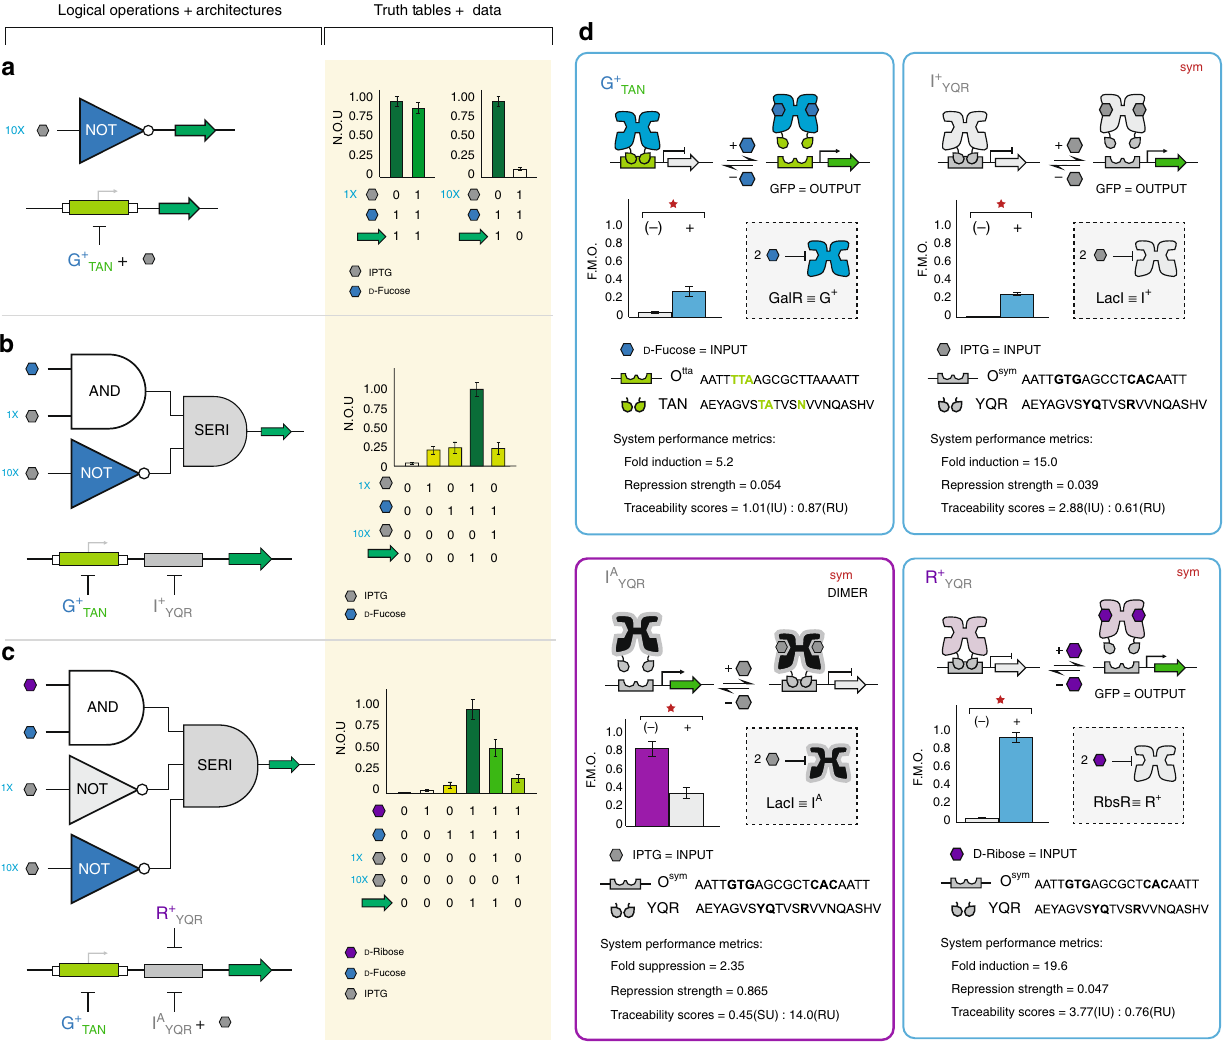
Fig. 6 Combinatorial logic via the SERI architectures and bandpass operations. a IPTG acts as a competitive inhibitor to GalR, preventing GFP expression upon addition of fucose in the presence of 10 mM IPTG. When 1 mM IPTG is present, GalR is not inhibited. Values represent the mean of n = 6 biological replicates, and the error bars represent the 95% CI or ~2x s.e.m. b NOT logic function can be incorporated into a SERI circuit by utilizing IPTG as a competitive inhibitor to GalR, resulting in an apparent bandpass fi lter, where GFP output is achieved only in the presence of certain IPTG concentrations. Values correspond to n = 18 biological replicates. c A second NOT gate can be added by introducing an I A transcription factor; this represents a more granular bandpass fi lter where the output can be gradually decreased upon addition of different concentrations of IPTG. Values correspond to n = 12 biological replicates except for the fucose, ribose, 1 mM IPTG state where n = 6 biological replicates. d Performance cards for each of the transcription factors involved. All data have been normalized to the maximum value of 20,000 GFP/OD 600 a.u. Note: the I A YQR suppressor used in c was reduced to a dimer (from a tetramer) to achieve repressor function. Source data provided as a Source Data fi le and individual data points overlaid as dot plots can be found in Supplementary Fig.